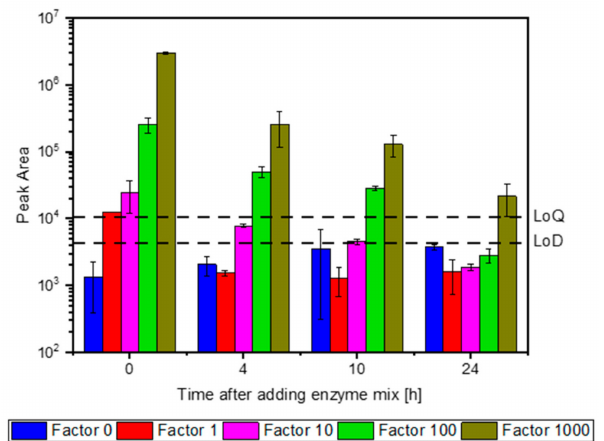
Figure 2. Degradation kinetics of the peptide IAL. The enzyme preparation was added in different dilutions to the biogas content and incubated over 24 h. IAL represents the ten selected peptides.